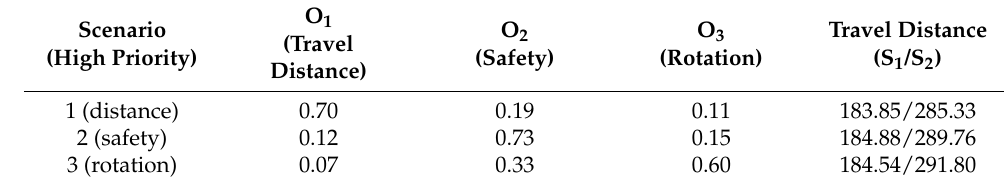
Figure 8. Hybrid algorithm-based path planning. Table 2. Travel distance of path-planning methods. Table 3. Weighting for each objective for Hybrid path planning and results.